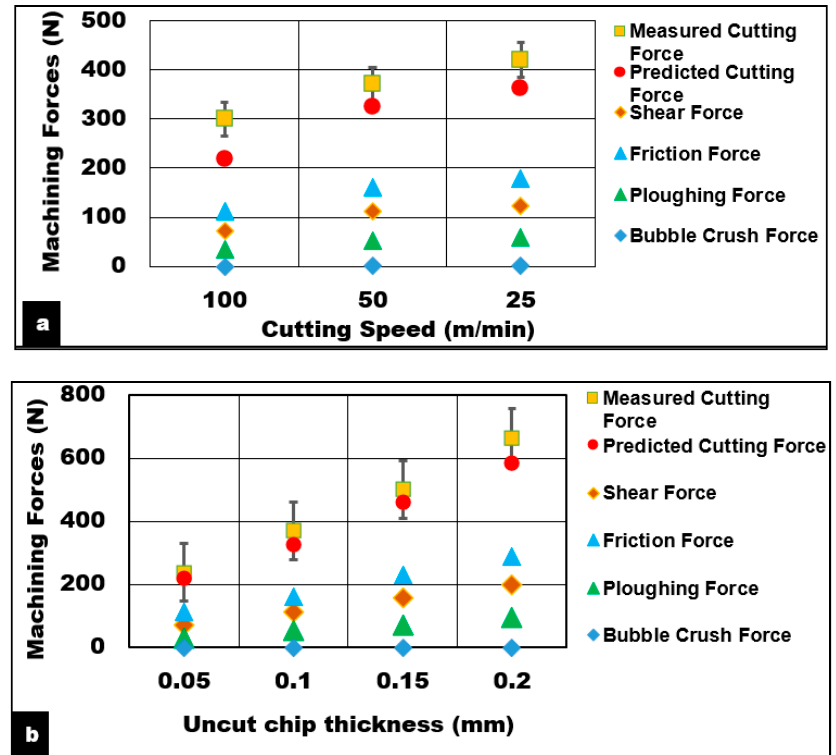
Figure 2. Effect of ( a ) cutting speed ( b ) uncut chip thickness on machining forces AZ31 Mg/hollow alumina syntactic foams (Volume fraction = 15%, h = 0.1 mm, b = 3 mm, Dry cut).